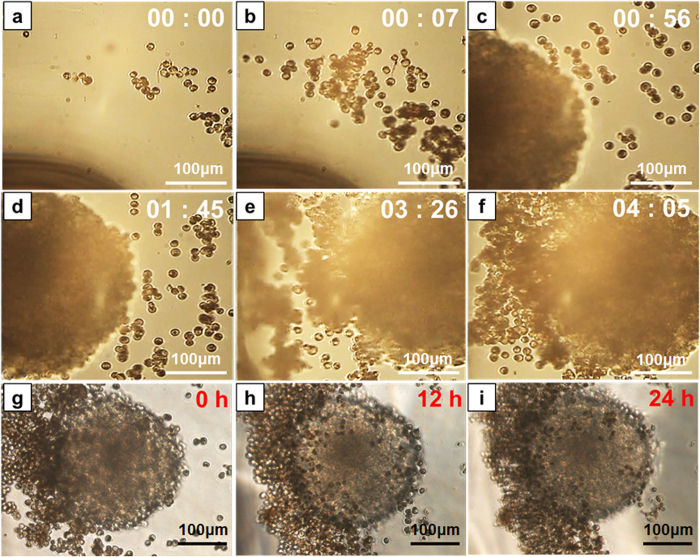
Evaluation of active tumor targeting of macrophage-based microrobots.(a–f) Active targeting of microrobots toward tumor spheroid using external magnetic field for 10 min (Scale bar 100 μm). (g–i) Tumor spheroid attachment property of the microrobots due to the intrinsic tumor infiltration characteristics of the macrophages (Scale bar 100 μm).